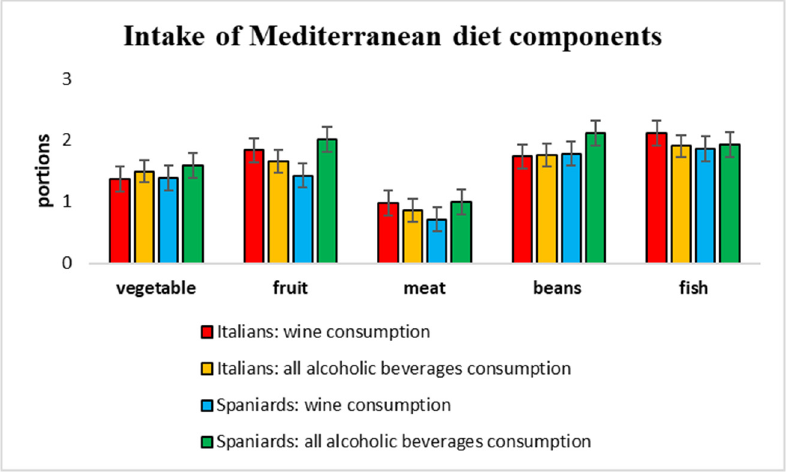
Figure 1. Consumption of the main components of the Mediterranean diet among drinkers. For each category of a food item, the average number of portions consumed by Italians and Spanish drinkers of only wine, or all alcoholic beverages, are reported. Data are means with standard deviation. Most of the students did not follow the MD pyramid recommendations for the con- sumption of vegetables ( ≥ 2/day), fruit ( ≥ 3/day), red meat (<1/day), beans ( ≥ 3/week), and fish ( ≥ 3/week). Differences between males and females, and Italian and Spanish subjects were not statistically significant; however, when data were stratified by place of residence, significant differences between Italians and Spaniards were observed among resident stu- dents (Table 4). Table 4. Percentage of students who complied with the recommended portion of Mediterranean diet components. MD Components